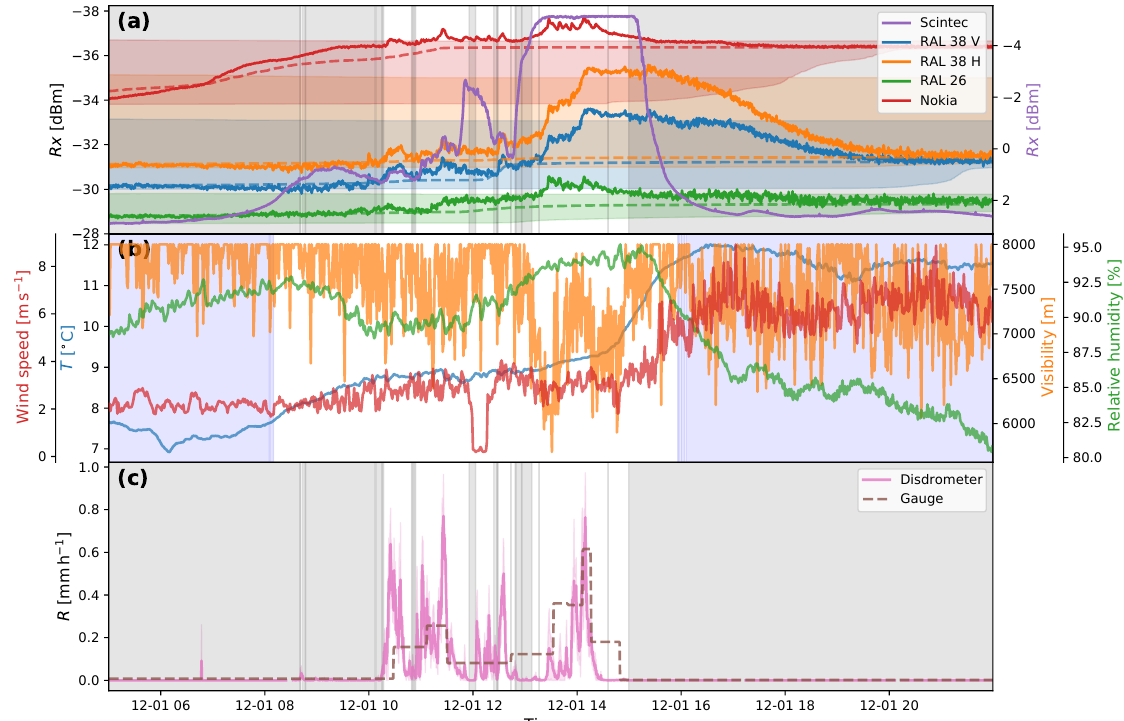
Figure 17. Time series of an event on 1 December 2015. (a) Received power levels at the detectors (solid lines) and reference levels (median over dry periods in a 24h moving window: dashed lines). The 5th and 95th percentile of power levels over dry periods in a 24h moving window are indicated by the coloured shading. (b) Several atmospheric variables measured at the “Veenkampen” meteorological station: relative humidity, visibility, and ambient air temperature at 2m, and wind speed indicated with blue, orange, green, and red lines, respectively. Periods with a negative net radiation flux at the surface are indicated with blue shading. (c) The spatial weighted average rainfall intensities derived from the disdrometers are indicated by the pink line, with the weighted standard deviation among the disdrometers indicated with the pink shaded area. The rainfall intensities derived from the tipping bucket gauge are indicated with the dashed line. Dry periods, as determined with the disdrometers, are represented by grey shaded